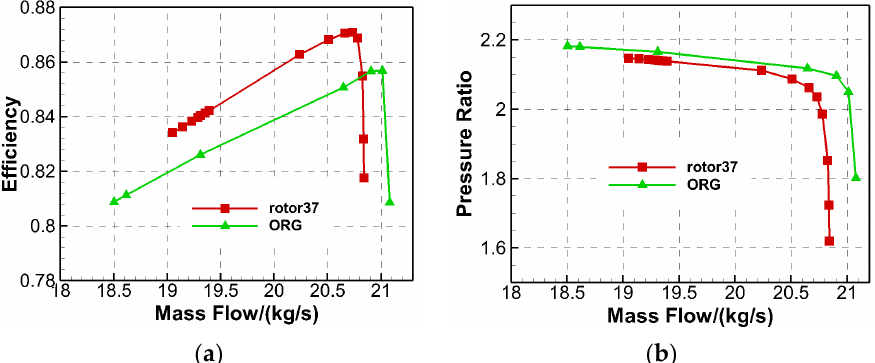
Figure 5. The characteristic comparison of Rotor37 and the original tandem rotor. ( a ) The isentropic efficiency; ( b ) the total pressure ratio.